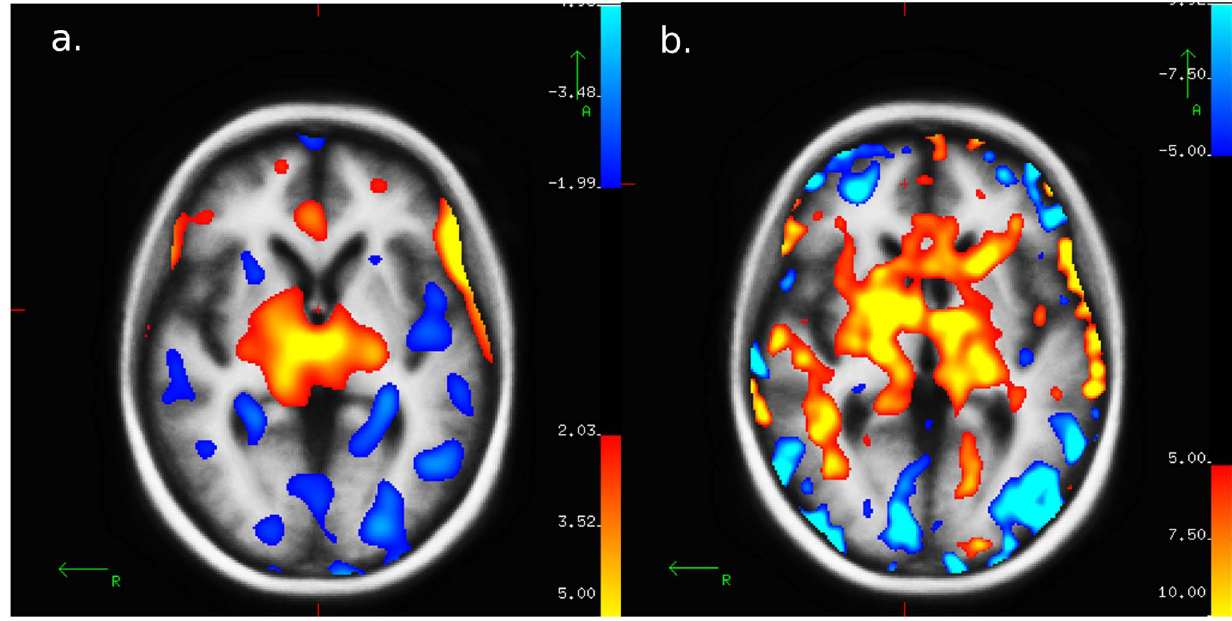
Figure 4. Quantitative regional cerebral blood flow during euglycemia and hypoglycemia in PET and PASL-MRI. Quantitative regional CBF (mL . 100 g 2 1. min 2 1 ) responses for euglycemia (black bars) and hypoglycemia (white bars) within a previously identified network. Significant increases in CBF were seen with hypoglycemia within the thalamus (THAL), globus pallidum (GP), and medial prefrontal cortex (MPF) for both A) PET and B) PASL-MRI. No significant increases were seen in the right orbitoprefrontal cortex (ROPF). *p ,